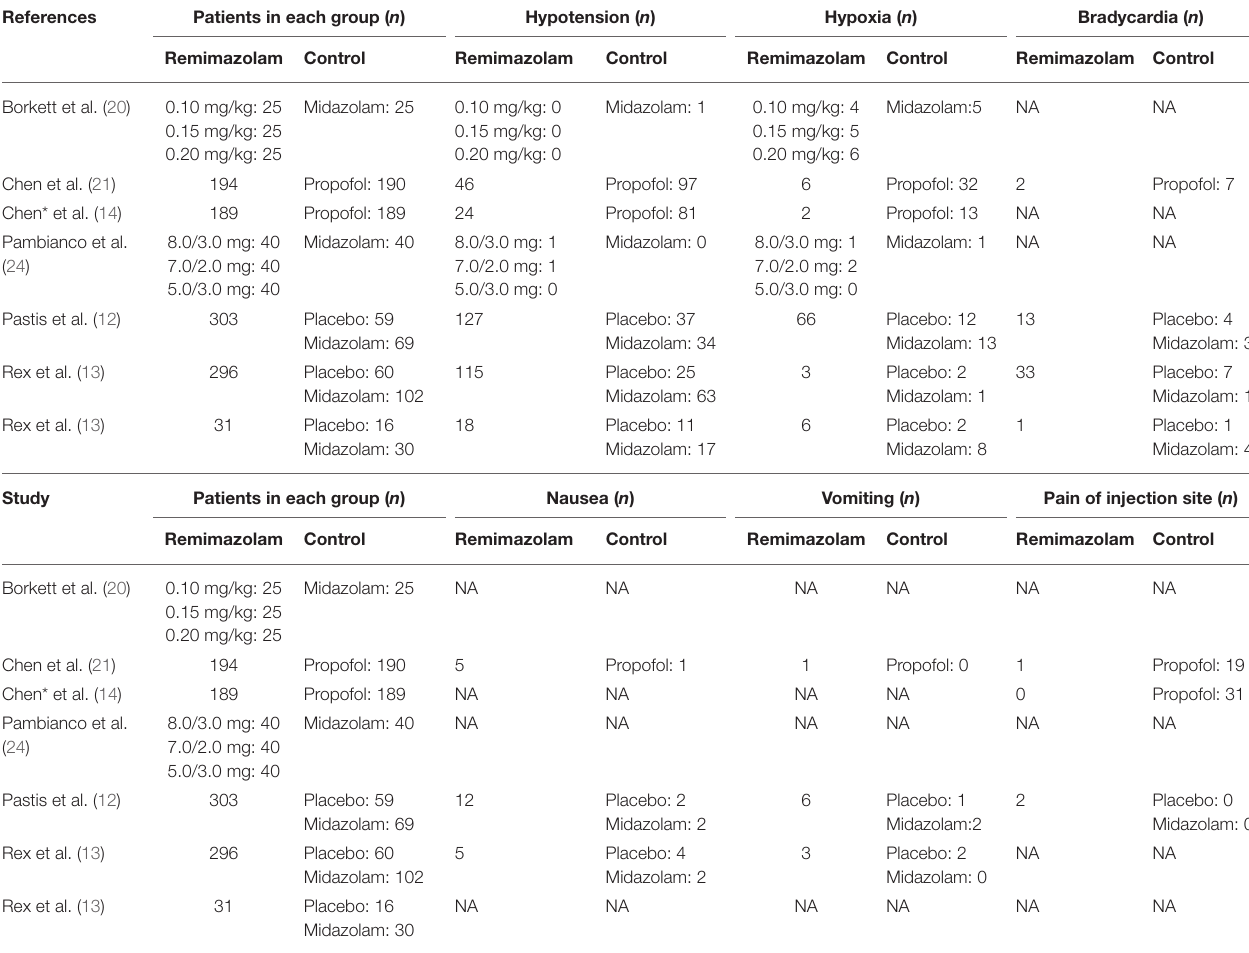
TABLE 3 | The number of patients with adverse events during endoscopy.